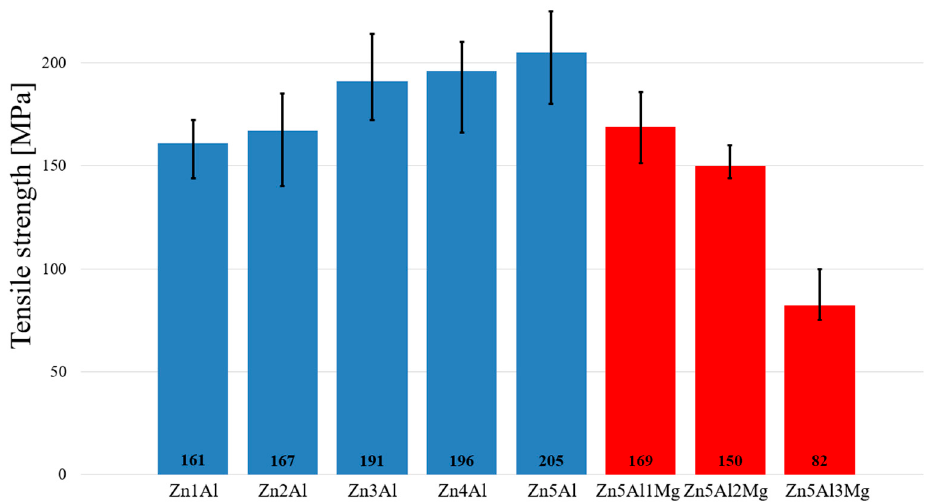
Figure 13. Tensile strength of Zn–Al–Mg soldering alloys depending on Al and Mg content.